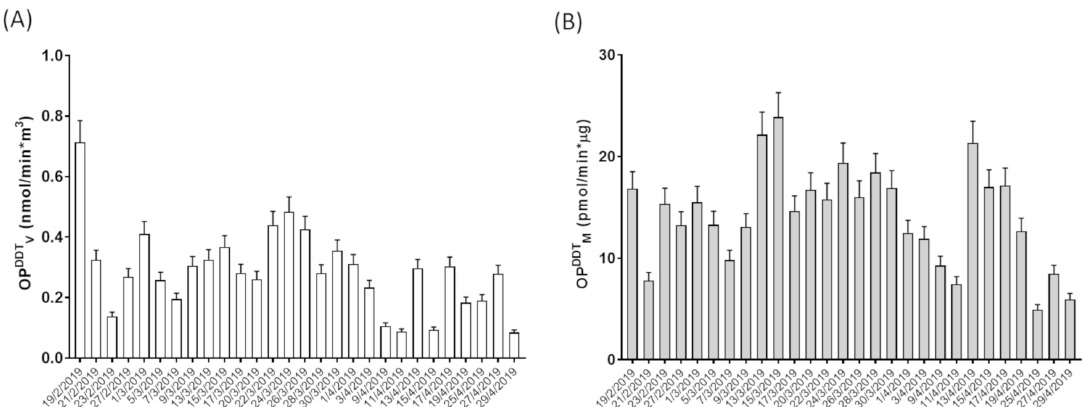
Figure 1. Oxidative potential expressed as OP DTT V ( A ) and OP DTT M ( B ) measured in aqueous extracts of the PM 10